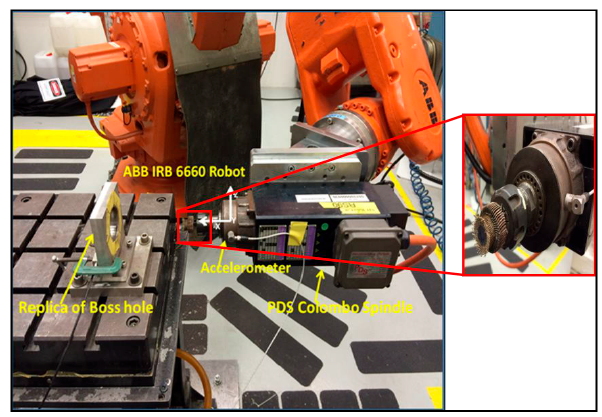
Figure 7. Trial and experimental setup.